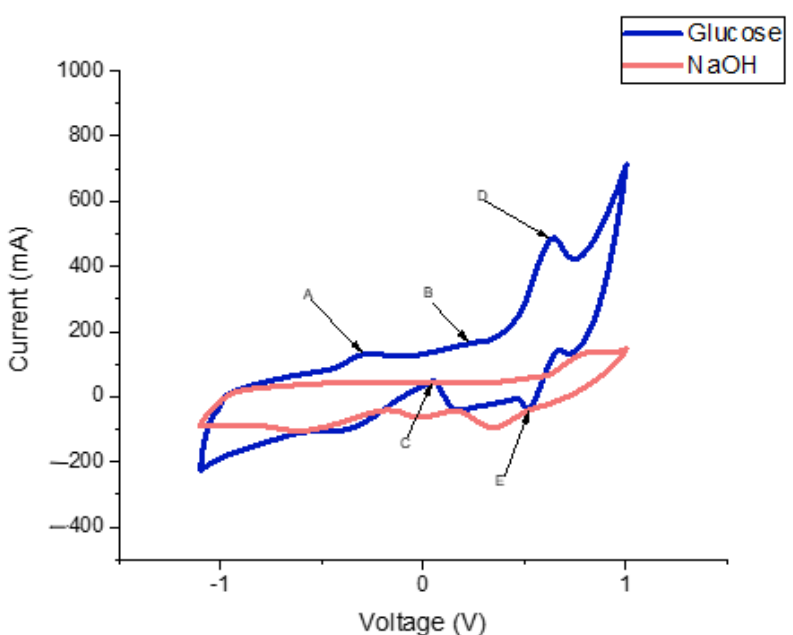
Figure 8. CV curve of the Au-Ni/AC modified screen-printed electrode using NaOH as a buffer. The red curve corresponds to NaOH without glucose. The blue curve corresponds to NaOH in the presence of glucose. From the blue curve it is possible to observe the oxidation peaks at peak A ( − 0.27 V), peak B (0.22 V), peak E (0.53 V), and peak D (0.66 V), and a reduction peak at peak C (0.04 V).